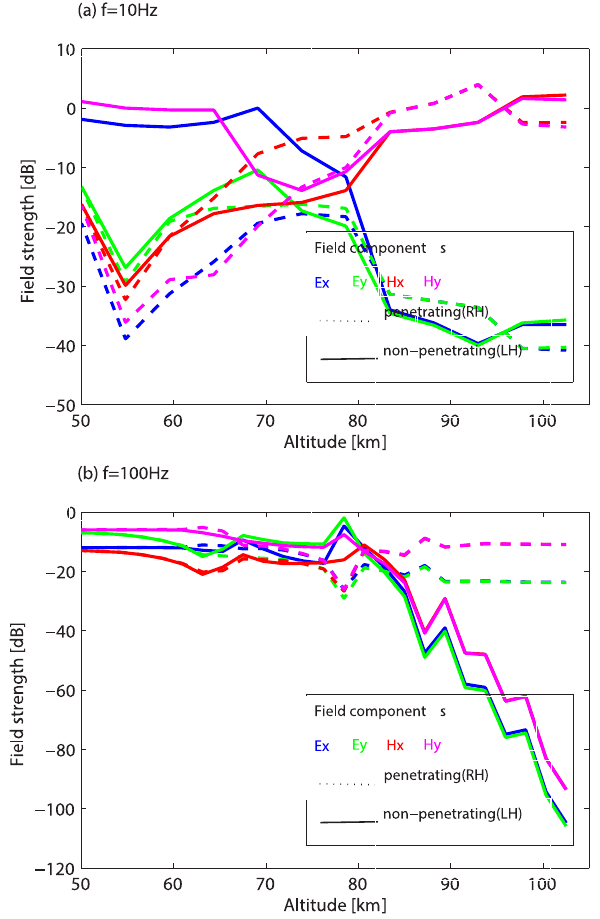
Figure 6. Intensity of four horizontal components of electric and magnetic field varying with altitude. Solid lines show intensity of the non-penetrating mode wave, and dashed lines show intensity of the penetrating mode wave at (a) 10Hz and (b) 100Hz. Blue lines represent E x , green lines represent E y , red lines represent H x , purple lines represent H y